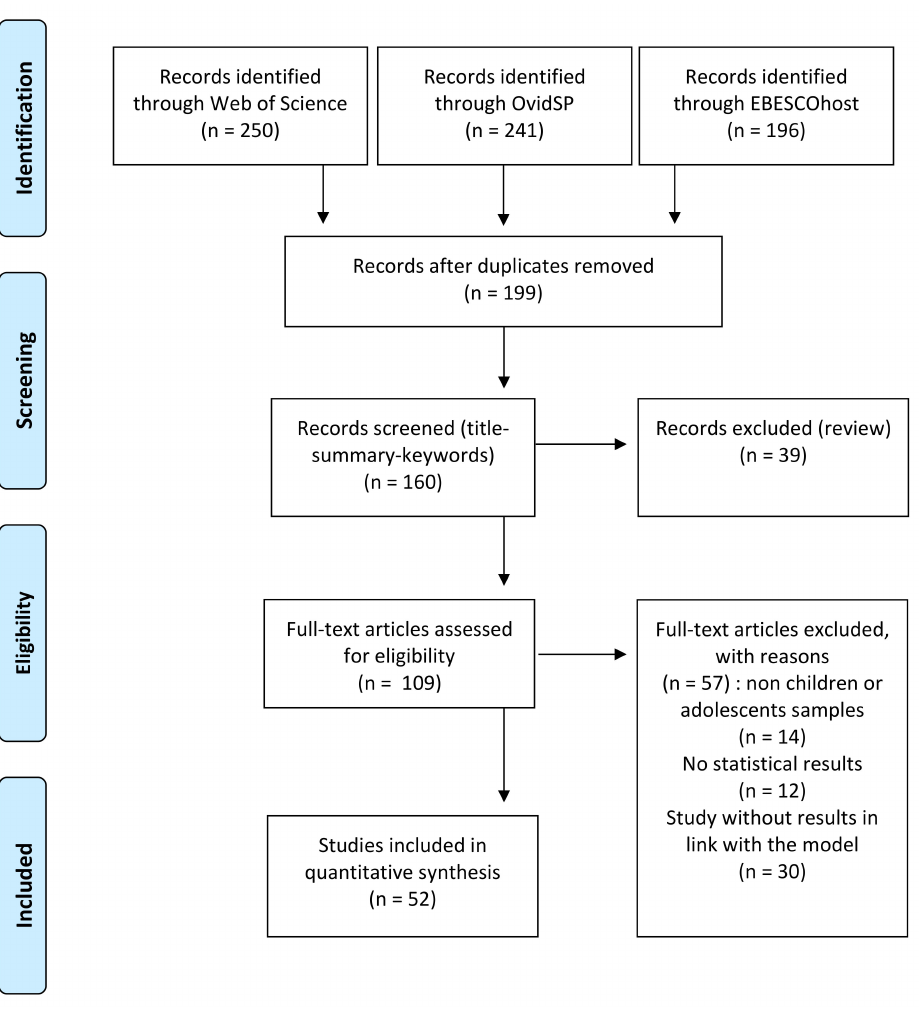
Figure 1. PRISMA flow